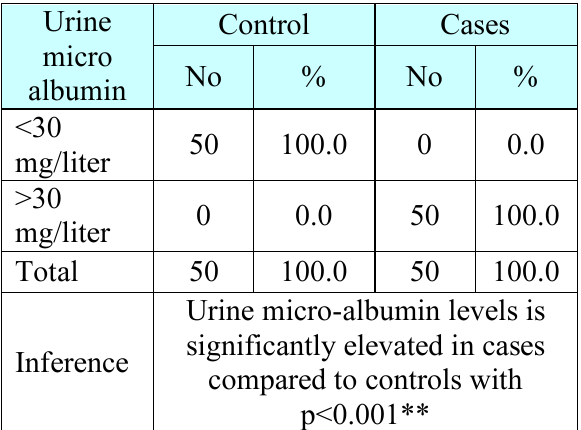
Table 3: Levels of microalbumin in urine in